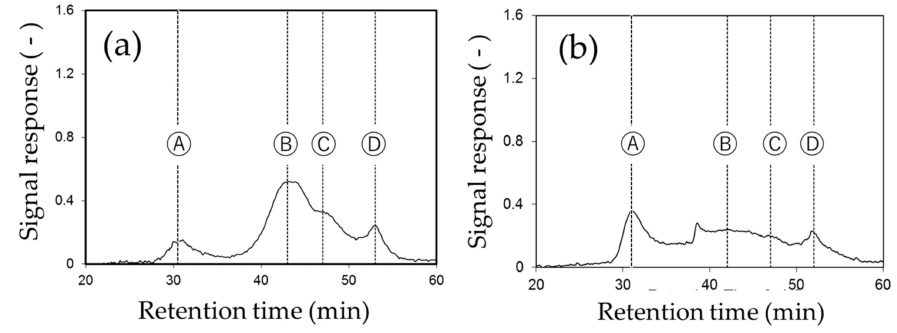
Figure 3. Chromatograph of ( a ) BCF influent and ( b ) fouling material measured by liquid chromatograph-organic carbon detector (LC-OCD). Ⓐ Biopolymer; Ⓑ Humic substances; Ⓒ Building blocks; and Ⓓ Acids.